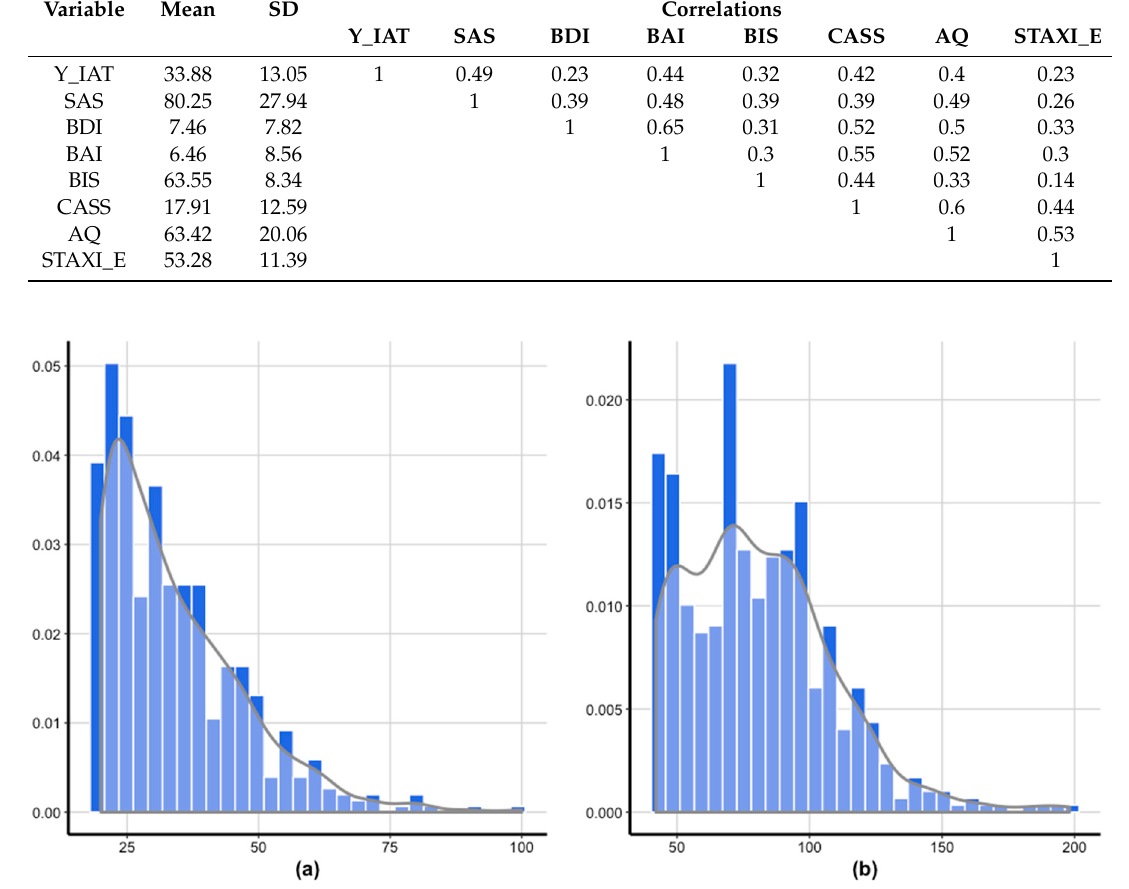
Figure 1. Histogram and density plot of the response variables: ( a ) Y-IAT; ( b ) SAS.